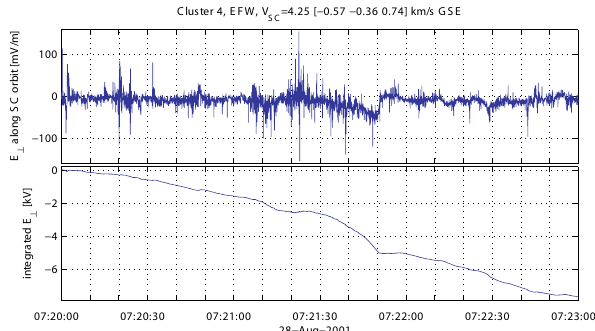
Fig. 11. The top panel is the projection of the electric field measured Figure 11 by EFW along the C4 spacecraft trajectory. The data are at a higher resolution than shown in Fig. 10. The second panel is the integral of this electric field along the spacecraft